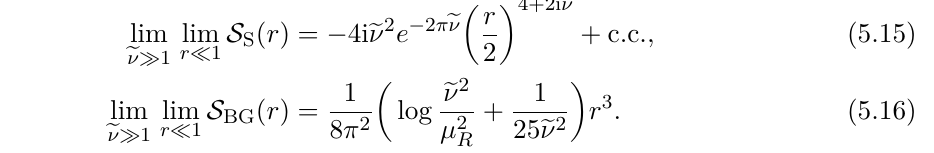
ν = 2 to make it visible. We use the dimensional e